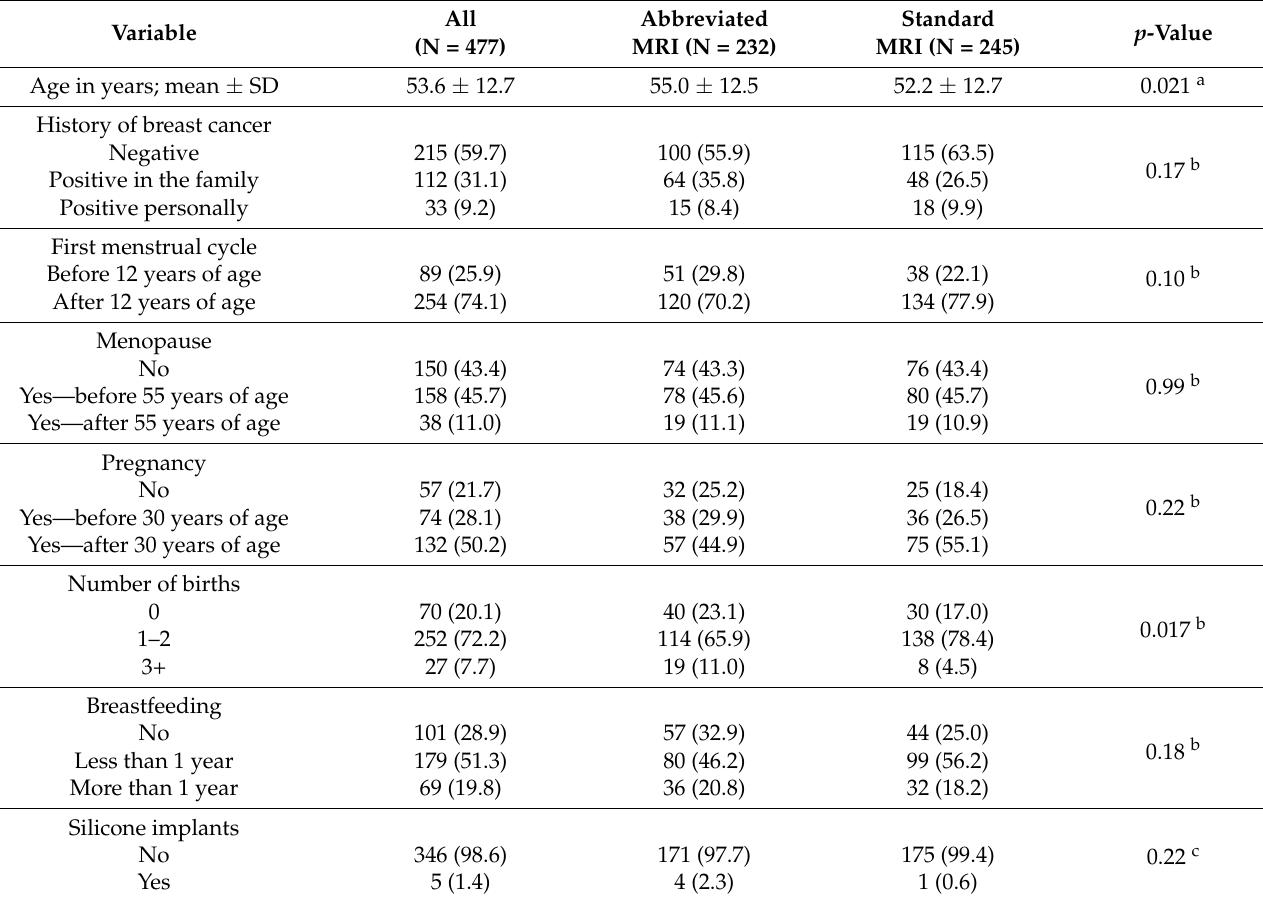
Table 1. Characteristics of patients referred for breast MRI according to MRI protocol (N =